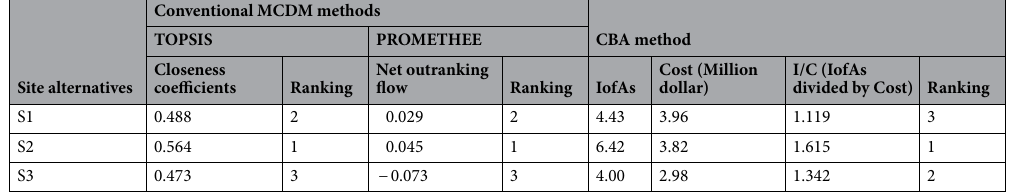
Table 5. The final ranking of the three methods.